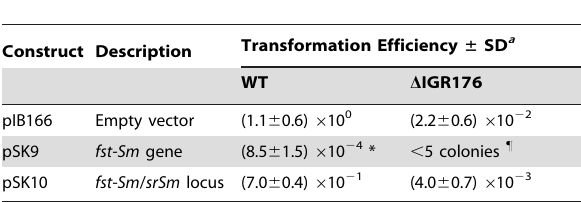
Table 3. S. mutans toxicity assay based on natural